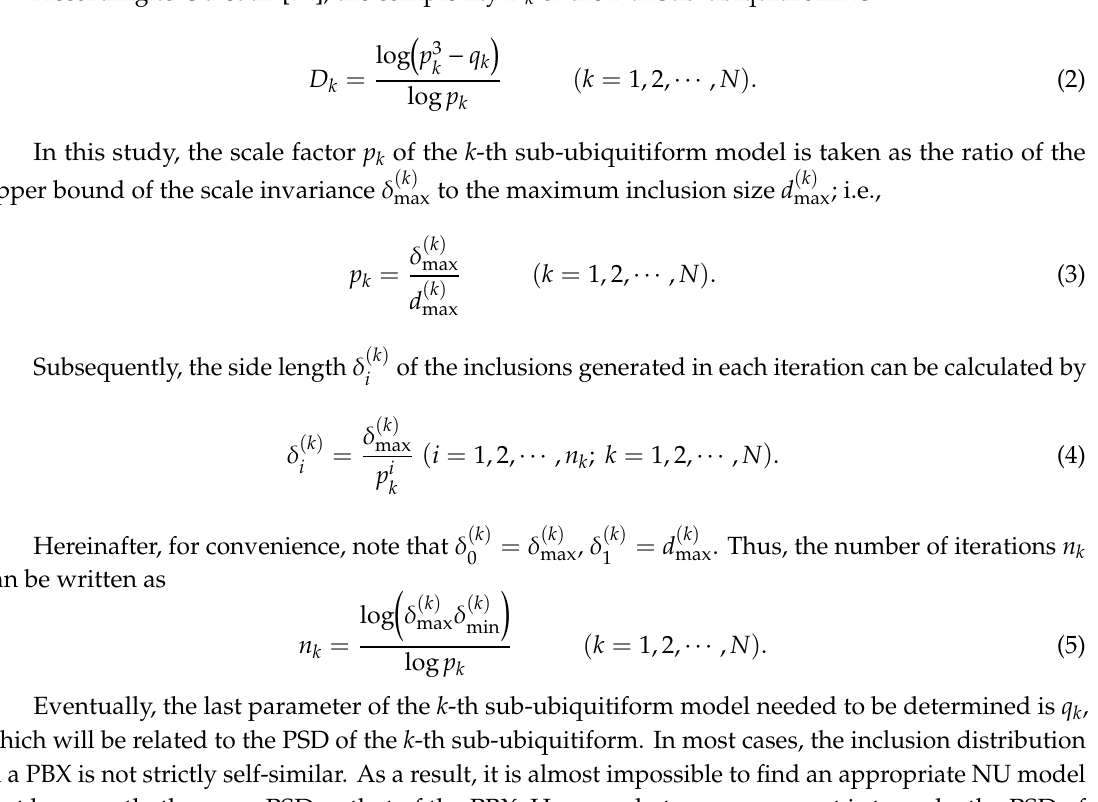
Figure 1. Two-dimensional two-layers nesting ubiquitiform (NU) model with p 1 = 3, n 1 = 2, q 1 = 1 and p 2 = 3, n 2 = 2, q 2 = 2. ( a ) The configuration of the first iteration of the first sub-ubiquitiform ( b ) The overall configuration of the two-layer NU model